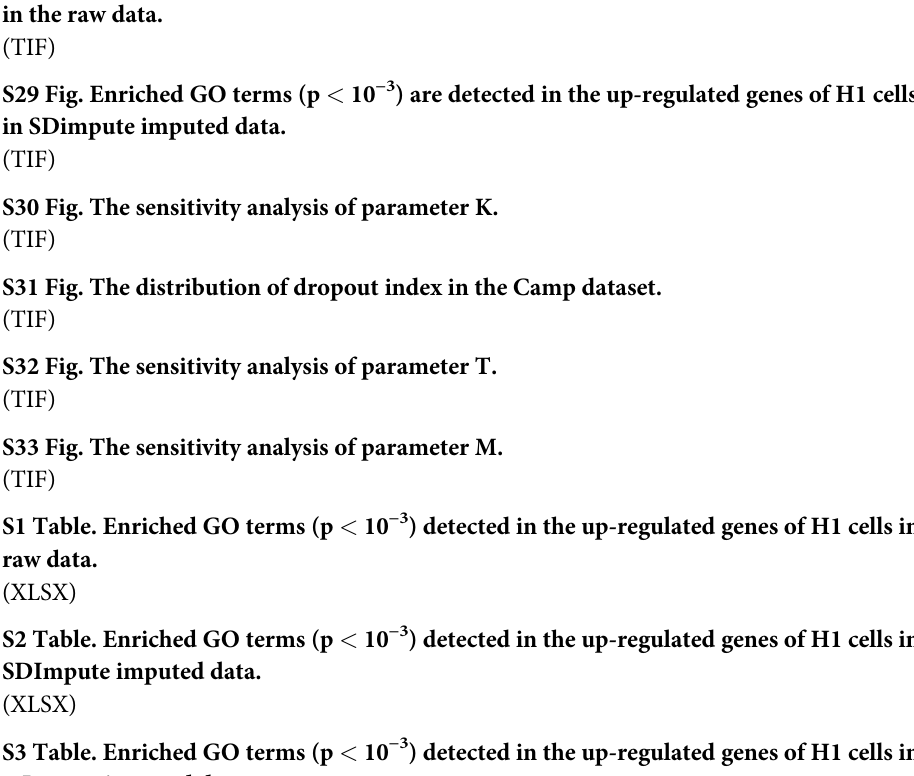
S27 Fig. Enriched GO terms (p < 10 − 3 ) are only detected in the up-regulated genes of H1 cells in the SDimpute imputed data. (TIF) S28 Fig. Enriched GO terms (p < 10 − 3 ) are detected in the up-regulated genes of H1 cells in the raw data. (TIF) S29 Fig. Enriched GO terms (p < 10 − 3 ) are detected in the up-regulated genes of H1 cells in SDimpute imputed data. (TIF) S30 Fig. The sensitivity analysis of parameter K. (TIF) S31 Fig. The distribution of dropout index in the Camp dataset. (TIF) S32 Fig. The sensitivity analysis of parameter T. (TIF) S33 Fig. The sensitivity analysis of parameter M. (TIF) S1 Table. Enriched GO terms (p < 10 − 3 ) detected in the up-regulated genes of H1 cells in raw data. (XLSX) S2 Table. Enriched GO terms (p < 10 − 3 ) detected in the up-regulated genes of H1 cells in SDImpute imputed data. (XLSX) S3 Table. Enriched GO terms (p < 10 − 3 ) detected in the up-regulated genes of H1 cells in scImpute imputed data. (XLSX) S4 Table. Enriched GO terms (p < 10 − 3 ) detected in the up-regulated genes of H1 cells in SAVER imputed data. (XLSX) S5 Table. Enriched GO terms (p < 10 − 3 ) detected in the up-regulated genes of H1 cells in MAGIC imputed data. (XLSX) S6 Table. Enriched GO terms (p < 10 − 3 ) detected in the up-regulated genes of H1 cells in DrImpute imputed data. (XLSX) S7 Table. Enriched GO terms (p < 10 − 3 ) detected in the up-regulated genes of H1 cells in VIPER imputed data. (XLSX) S8 Table. Enriched GO terms (p < 10 − 3 ) detected in the up-regulated genes of H1 cells in DCA imputed data.